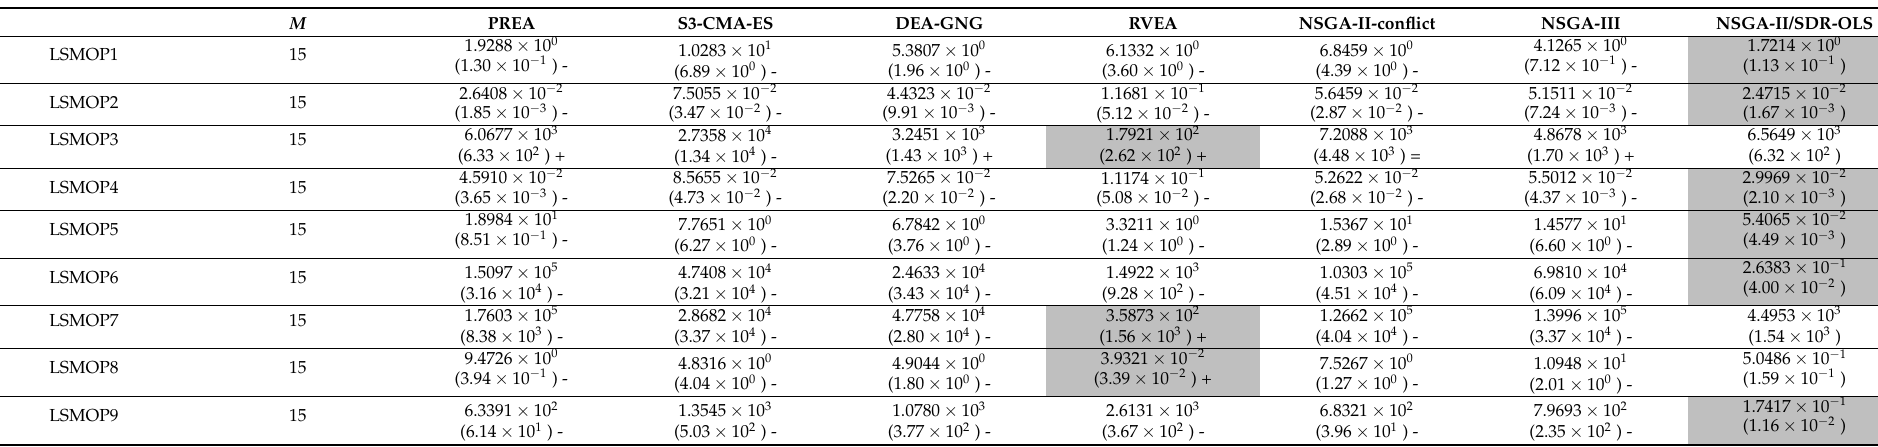
The gray background represents that this algorithm has the best performance on this problem. The number in the brackets represents the standard deviation, and the number out of the brackets represents the mean values. “+/-/=” means that the relevant algorithm performs better than/worse than/as well as the NSGA-II/SDR-OLS algorithm. Same below table. Table 17. GD values for 9 fifteen-objective benchmark